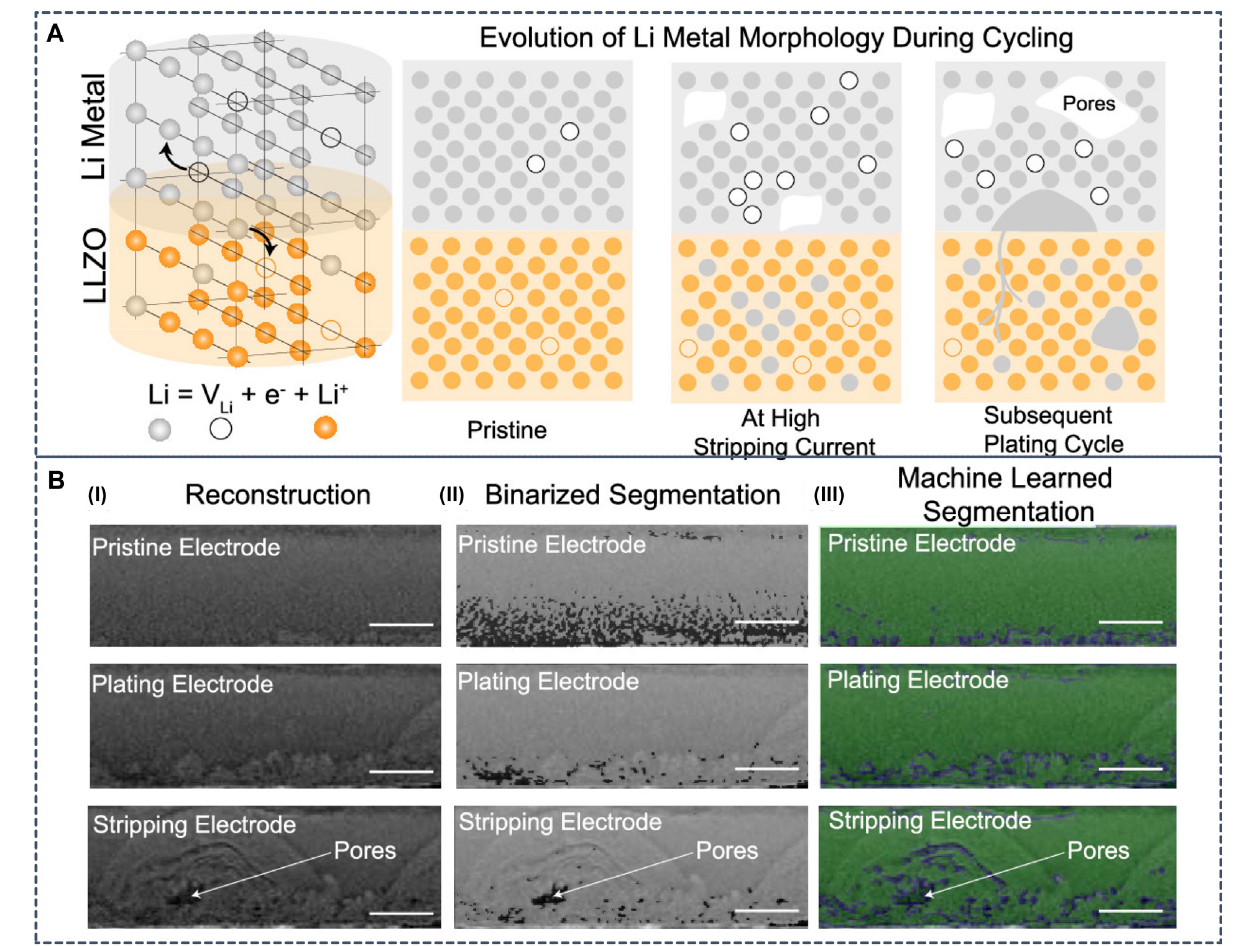
FIGURE11|(A) Schematicdiagram oftheinterfacialtransportchallengesinlithiummetalsolid-statebatteries.Lithium metalundergoesoxidation and migrates as Li + to the solid electrolyte leaving an electron and a vacancy in the lithium metal. During stripping at high current densities, the vacancies formed due to Li + migration accumulate faster than can be replenished by self-diffusion of Li metal. This results in formation of voids at the anode|SE interface. On subsequent cycling, the void acts as focusing regions for nonplanar Li deposition (B-I) Sample reconstruction slices of the lithium metal electrode imaged for pristine, plating, and stripping steps. Semicircular morphologies are observed in the plating as well as stripping electrode, and pore formation in the stripping electrode is observed (B-II) Segmentation from the conventional binarization process overlaid with raw reconstruction images. Darker regions in these images are identi fi ed pores/void phase while the lighter domains are lithium metal (B-III) Segmentation results from convolutional neural networks overlaid withraw reconstruction images. Thegreenphase istheidenti fi edlithiummetal while the blue phase is the identi fi ed pore/void phases. Reproduced with permission from (Dixit et al., 2020). Copyright 2020 American Chemical Society.